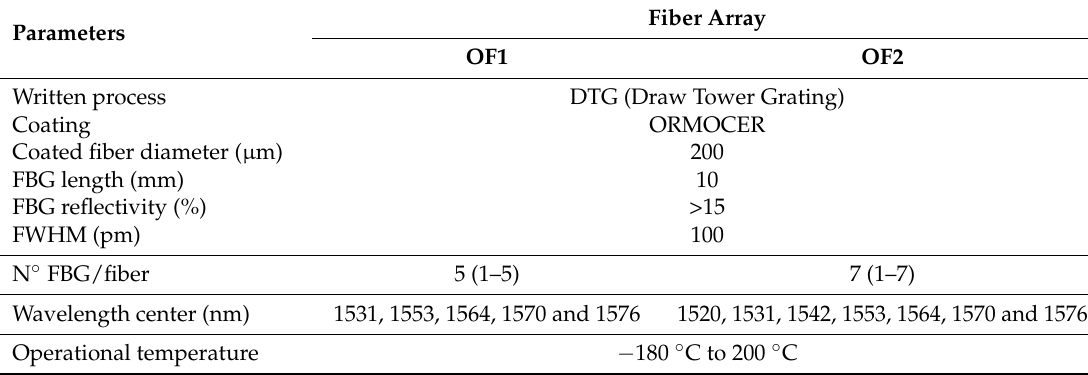
Table 1. Main features of the FBG arrays.